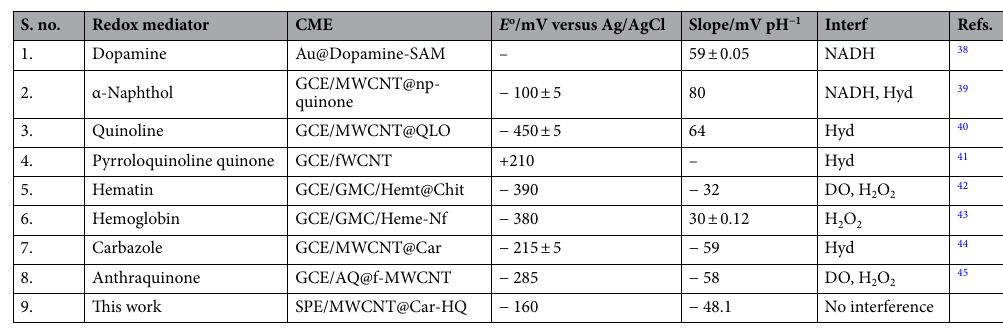
Table 1. Comparison of electroanalytical data of pH sensing by SPE/MWCNT@Car-HQ with several literature-based voltammetric sensing systems. DO dissolved oxygen, Hyd hydrazine, Car carbazole, Ppy